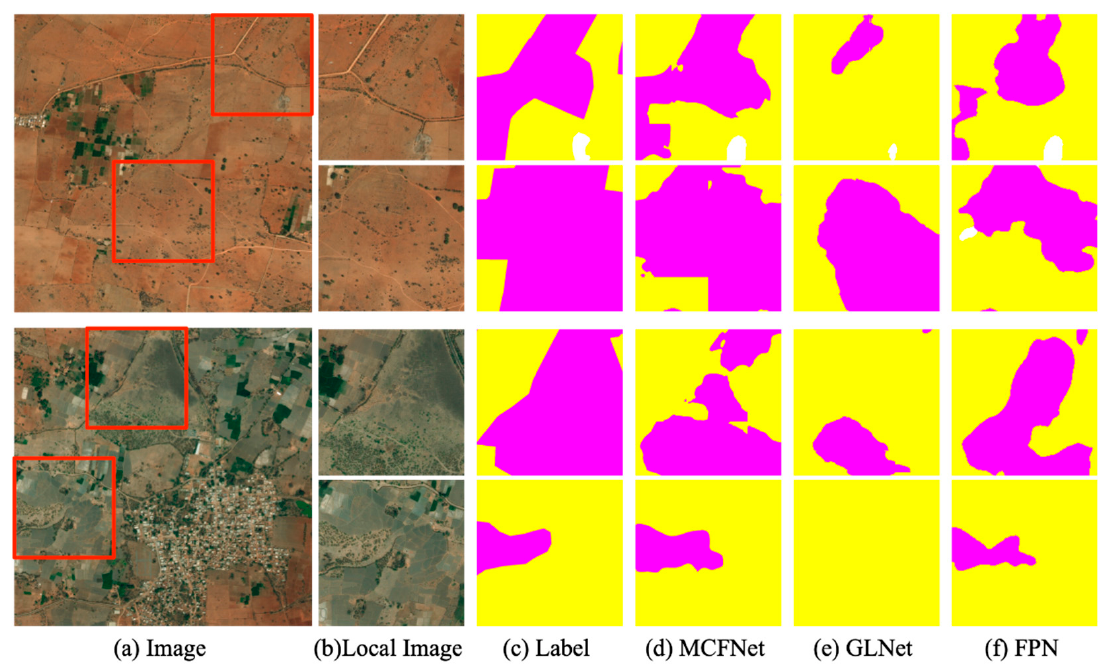
Figure 8. Visualization of semantic segmentation results for ambiguous categories Agriculture and Rangeland.